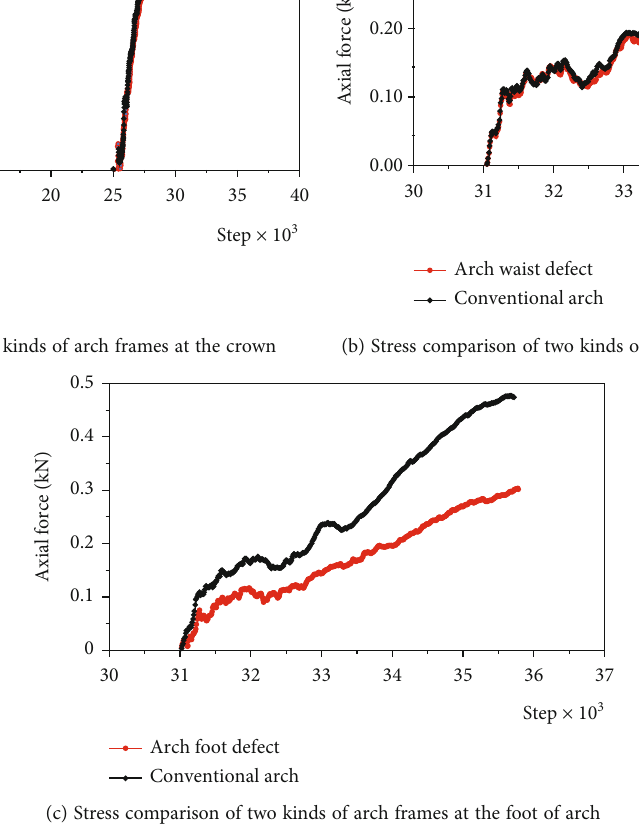
Figure 12: Stress comparison of two arch frames at the same